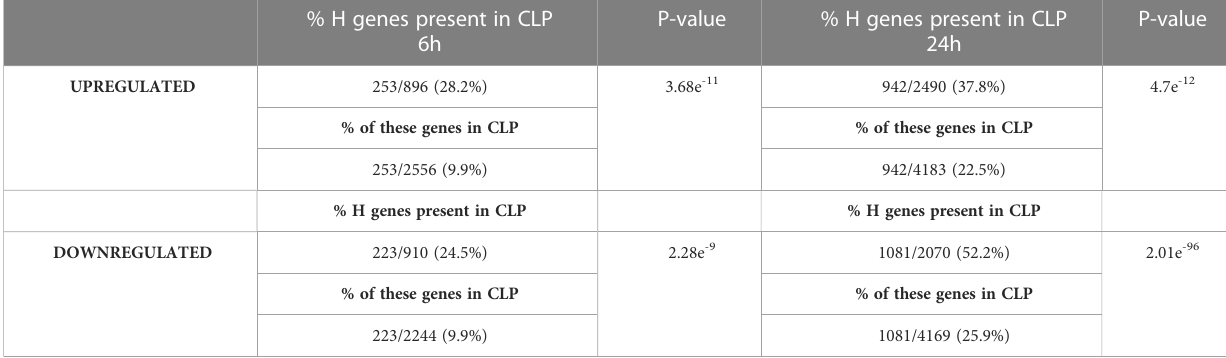
TABLE 2 The presence of hypoxia signaling after CLP-induced polymicrobial sepsis.